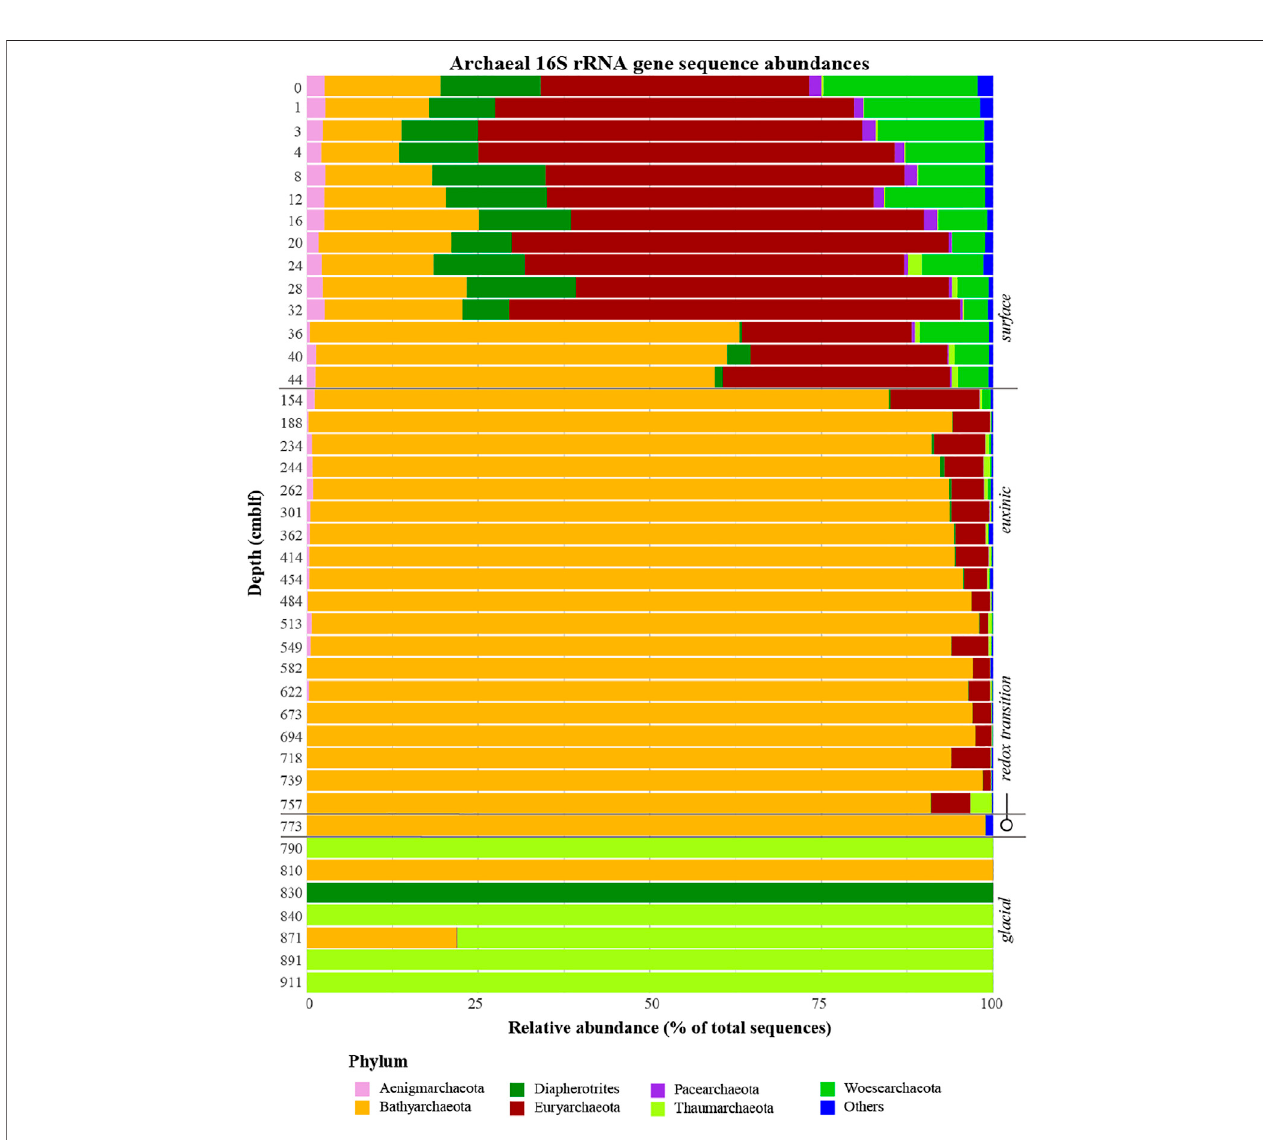
Frontiers in Earth Science |